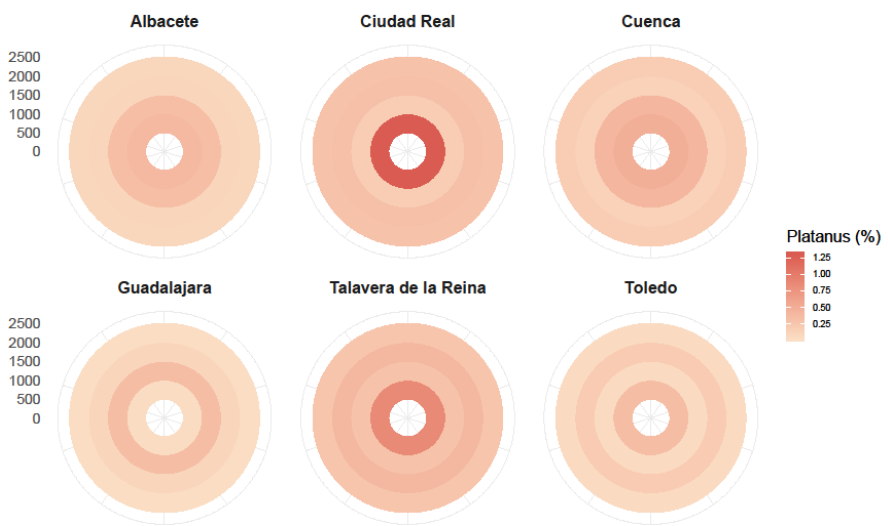
Figure 6. Concentric rings showing the percentage of the surface of Platanus in the main urban green zones for the studied cities.